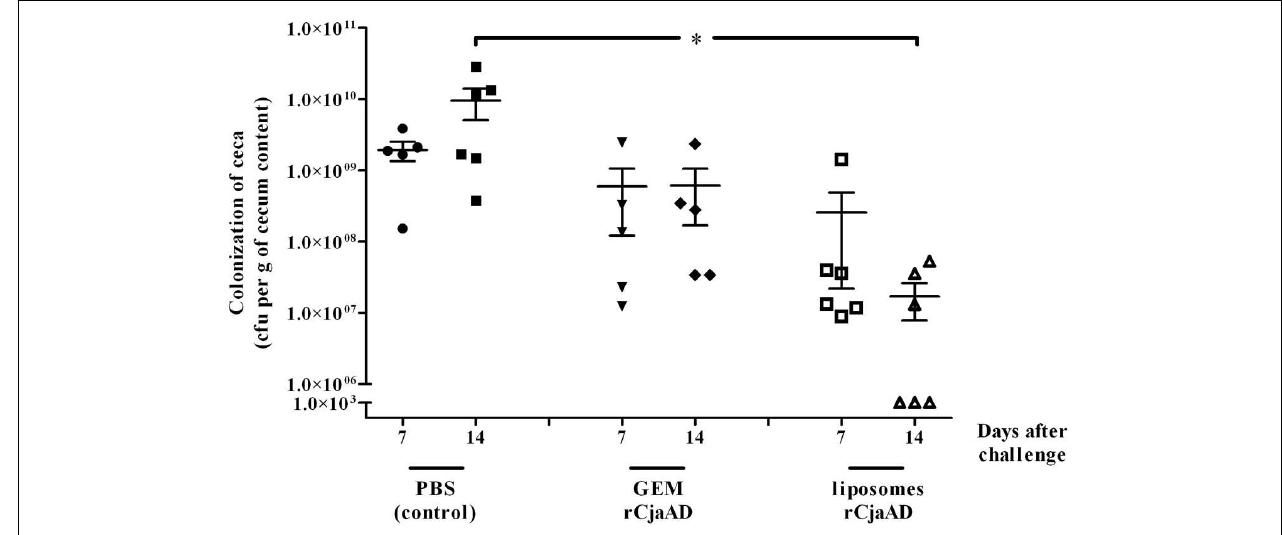
FIGURE 2 | Colonization of chickens vaccinated in ovo with: GEM particles presenting rCjaAD-LysM on their surface or liposomes containing rCjaAD, and then given a C. jejuni challenge. 18-day-old embryonated chicken eggs were inoculated with 0.1 ml GEM particles or liposomes and challenged with C. jejuni /pUOA18 on day 14 of life. Control birds were given PBS. Viable C. jejuni cells were recovered from the ceca of chickens 7 and 14 days after challenge. Bacterial recoveries represent colonization levels of 5 or 6 birds per time interval. The geometric mean for each group is denoted by bars. Asterisks indicate significant differences ( p < 0.05) between analyzed groups and control group.